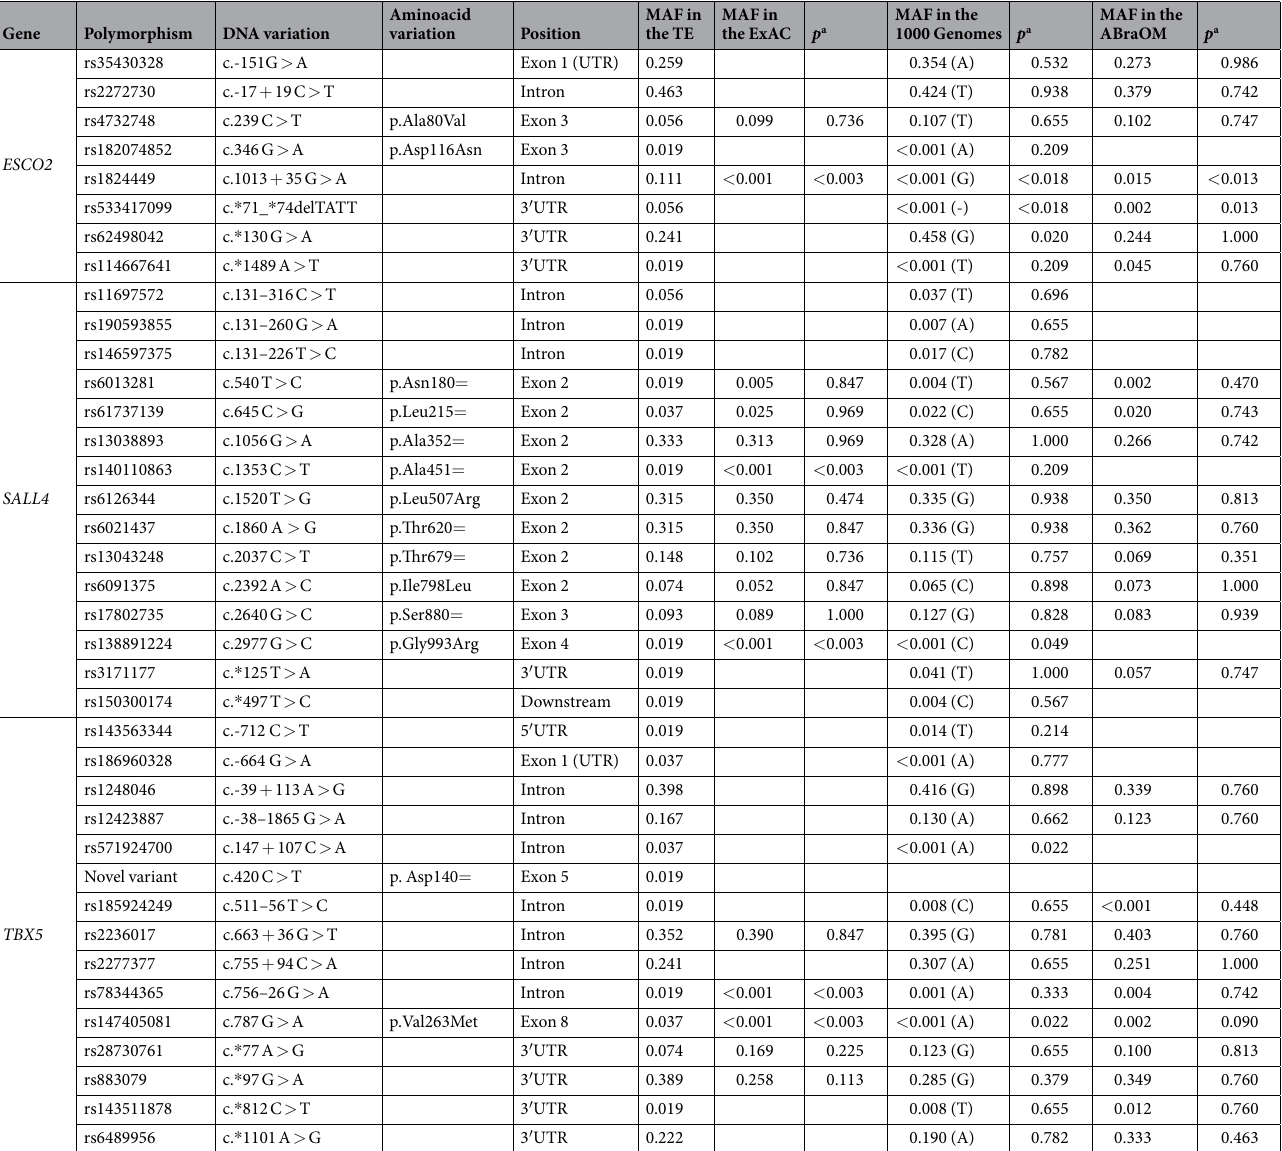
Table 3. Allelic frequencies of the variants found in the individuals with Thalidome Embryopathy compared to the ones of different databases. Reference sequences are: ESCO2 transcript NM_001017420, SALL4 transcript NM_020436 and TBX5 transcript NM_000192. a With FDR